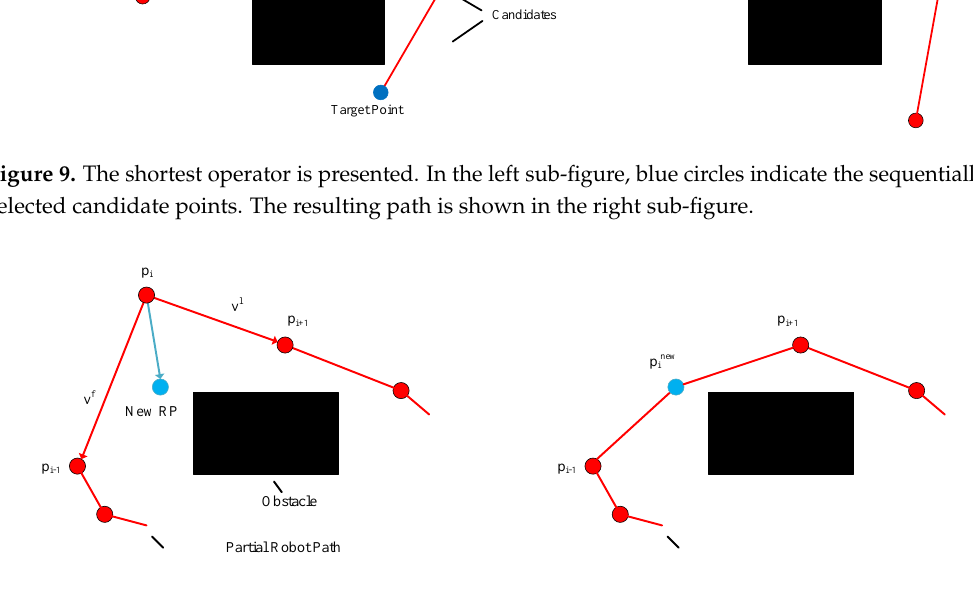
Figure 10. The position update operator is displayed. In the left sub-figure, some line segments of a path are shown. For three consecutive rotation points on the path, the new position of the middle point can be generated using Equation (5) and represented by a blue circle. The right sub-figure presents some line segments of the new